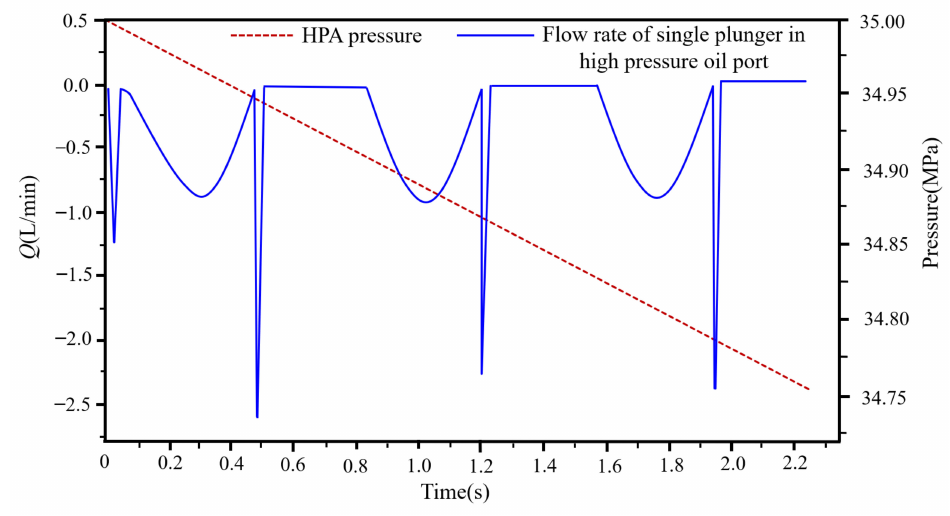
Figure 7. Diagram of HPA pressure and single plunger flow rate at high pressure oil port on motor analysis.